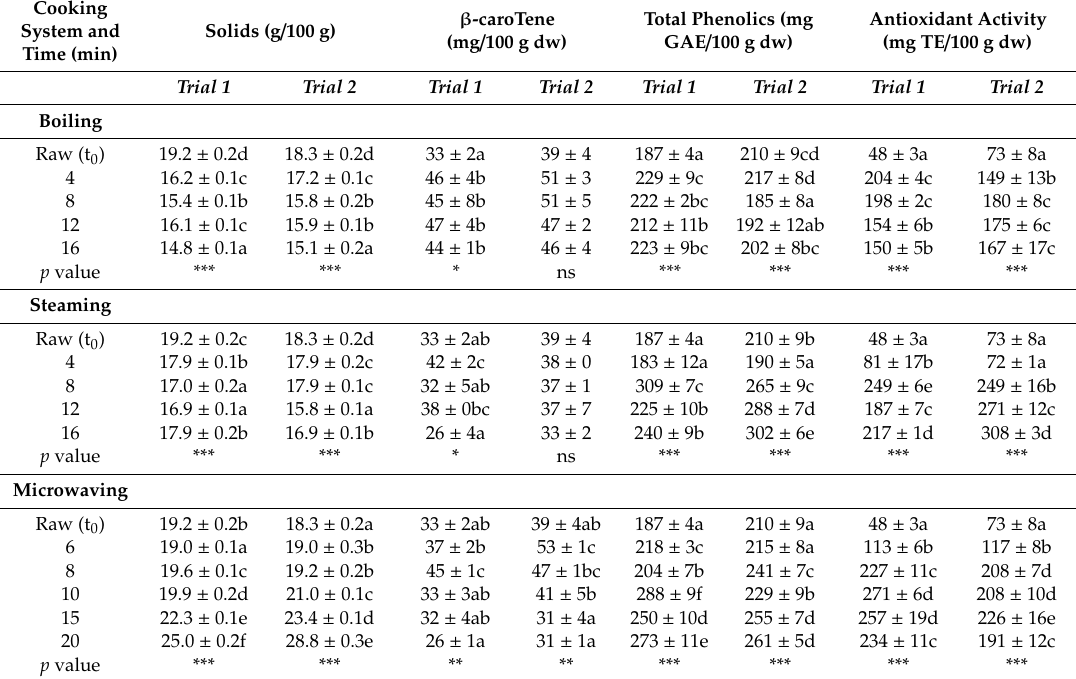
Table 3. Nutritional properties of sweet potatoes cooked by di ff erent cooking systems and times. Cooking System